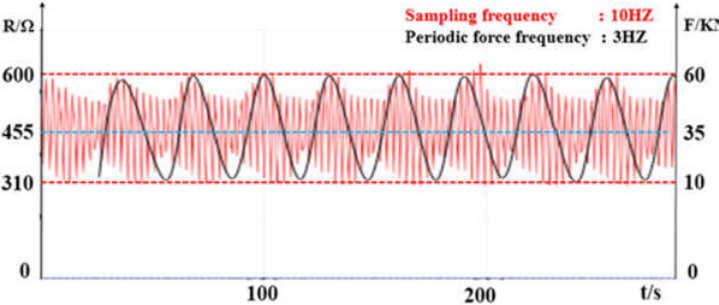
Figure 11. Waveform diagram of Sensor resistance signal and periodic force with time.